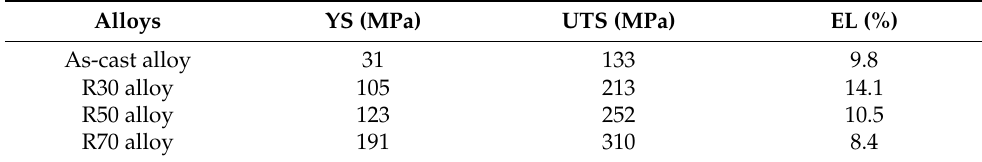
Table 1. YS, UTS, and EL of as-cast and hot rolled Mg-5Sn alloys. Alloys YS (MPa) UTS (MPa) EL (%) As-cast alloy 31 133 R30 alloy 105 R50 alloy 123 252 R70 alloy 191 310